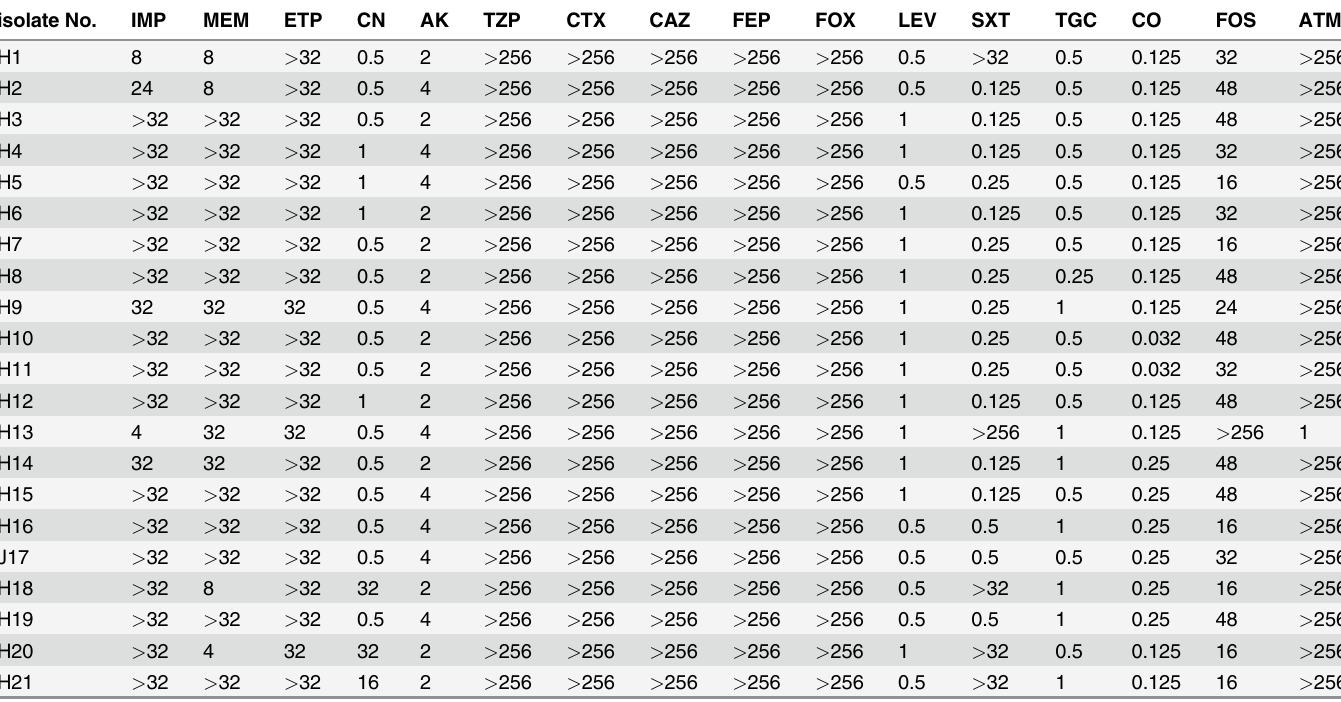
Table 2. The antibiotic susceptibility of blaNDM-producing k . pneumonia ( μ g/ml). isolate